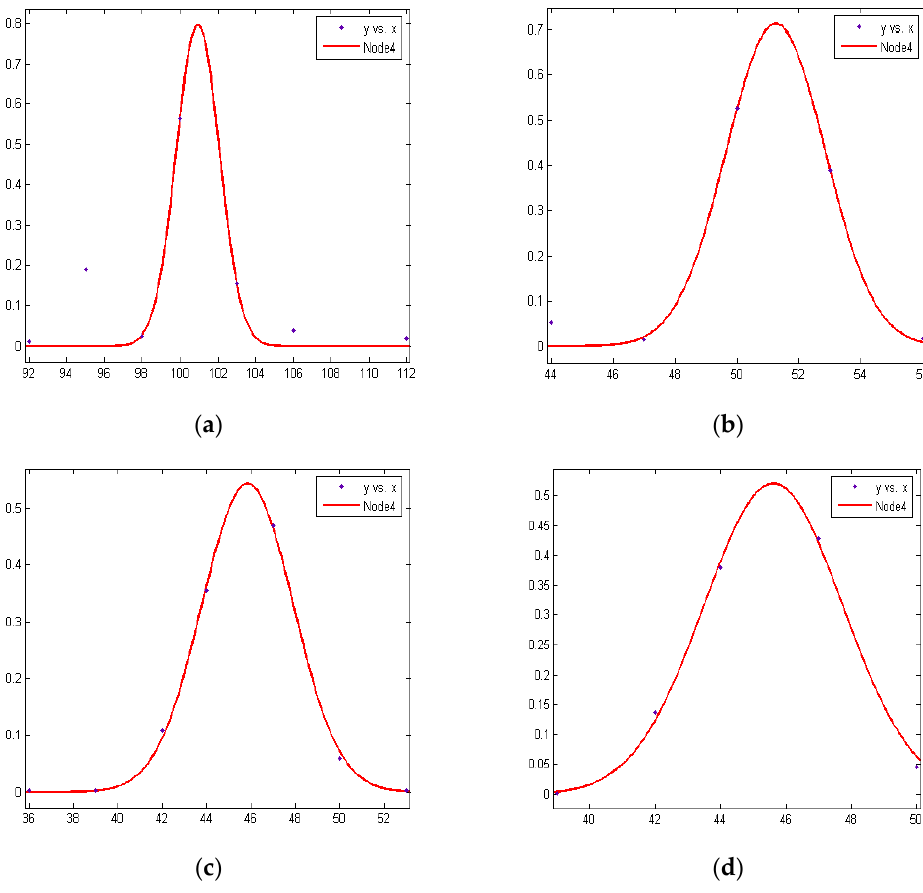
Figure 2. RSSI fitting of Node 4 at ( a ) 1 m; ( b ) 2 m; ( c ) 3 m; and ( d ) 4 m, respectively. Table 2. Calculation results of n at different distances.